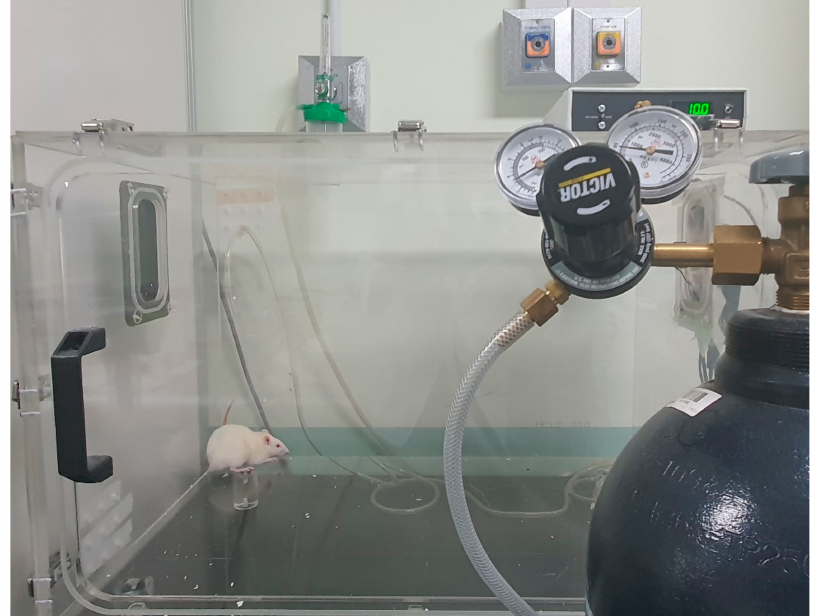
Figure 1. Hypoxic chamber with 10% oxygen. Animals sojourned for 2 ( n = 10), 4 ( n = 10), and 8 h per day ( n = 10) in one identical commercially designed chamber (30 × 320 × 320 inches) for five days. Deviations from the desired concentration were corrected by the addition of N 2 through solenoid valves.